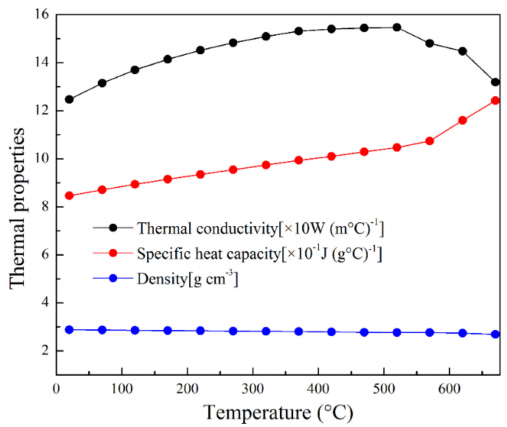
Figure 1. Thermal properties of 7055 alloy.